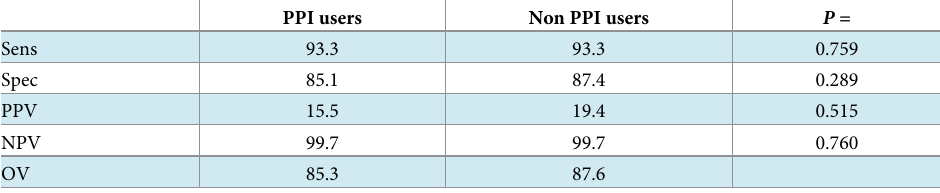
Table 4. Diagnostic accuracy of positive faecal immunochemical test (FIT (cid:21) 20 μg/g) for colorectal cancer accord- ing to PPI treatment.